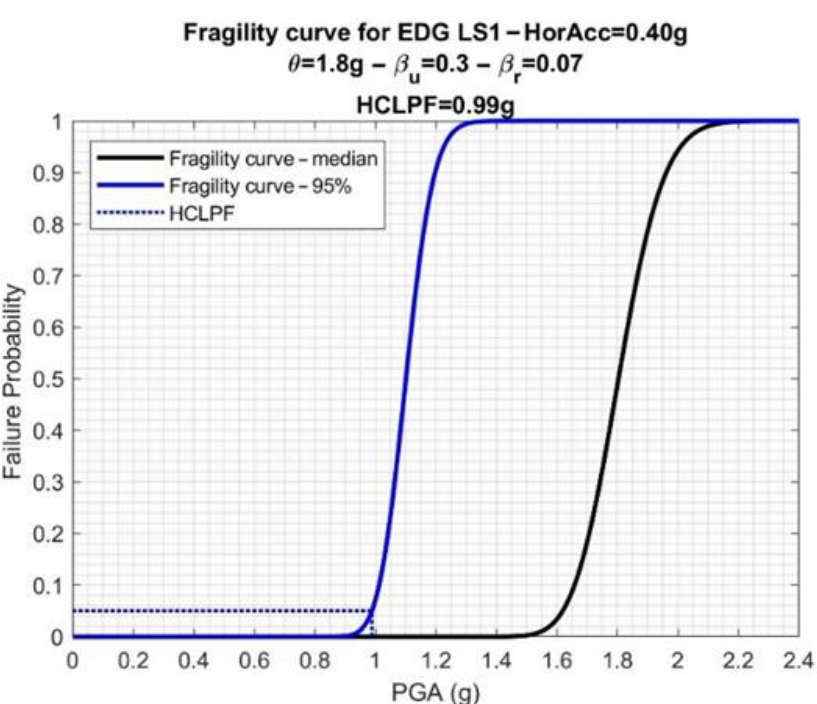
Figure 14. Fragility curve for EDG LS1—horizontal acceleration = 0.40 g.